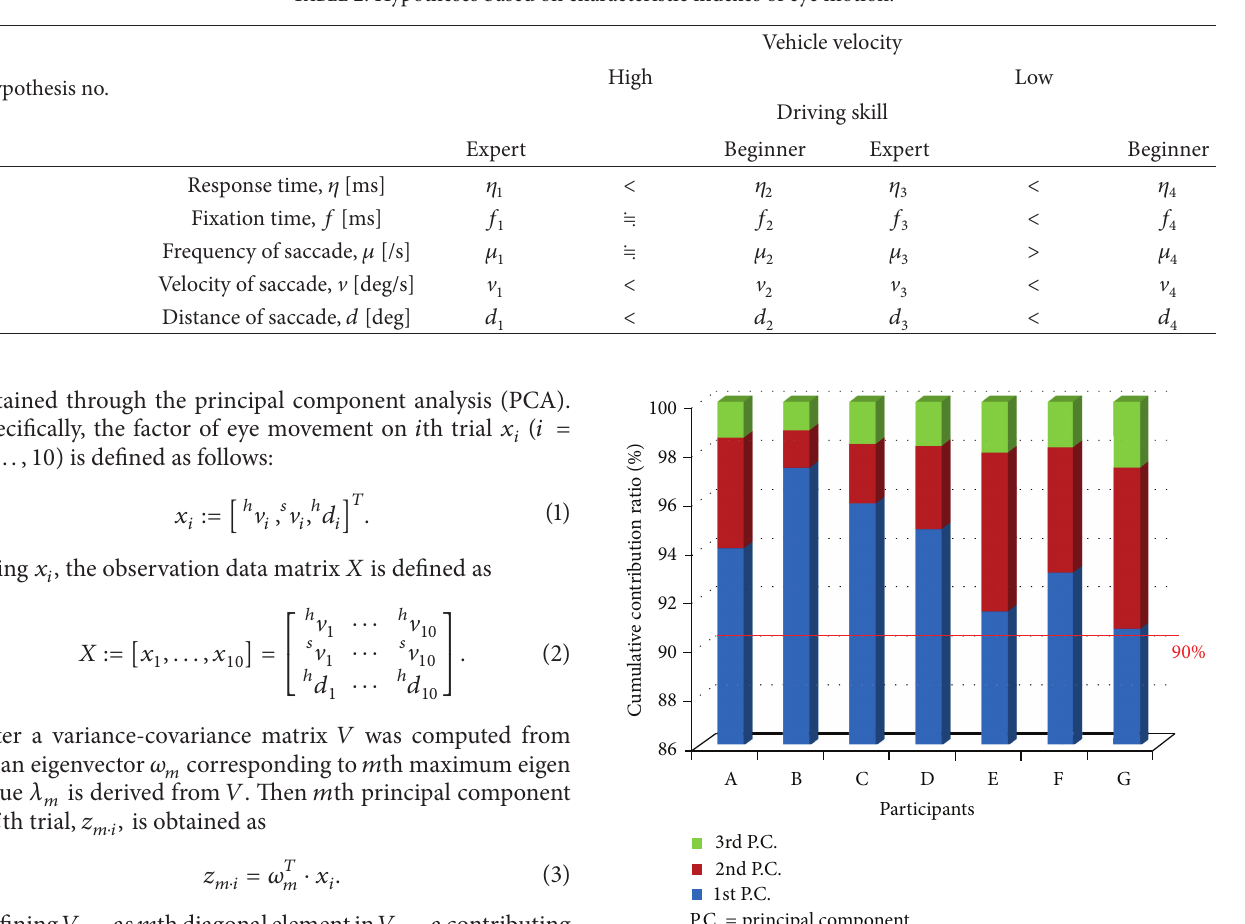
Table 2: Hypotheses based on characteristic indexes of eye motion.